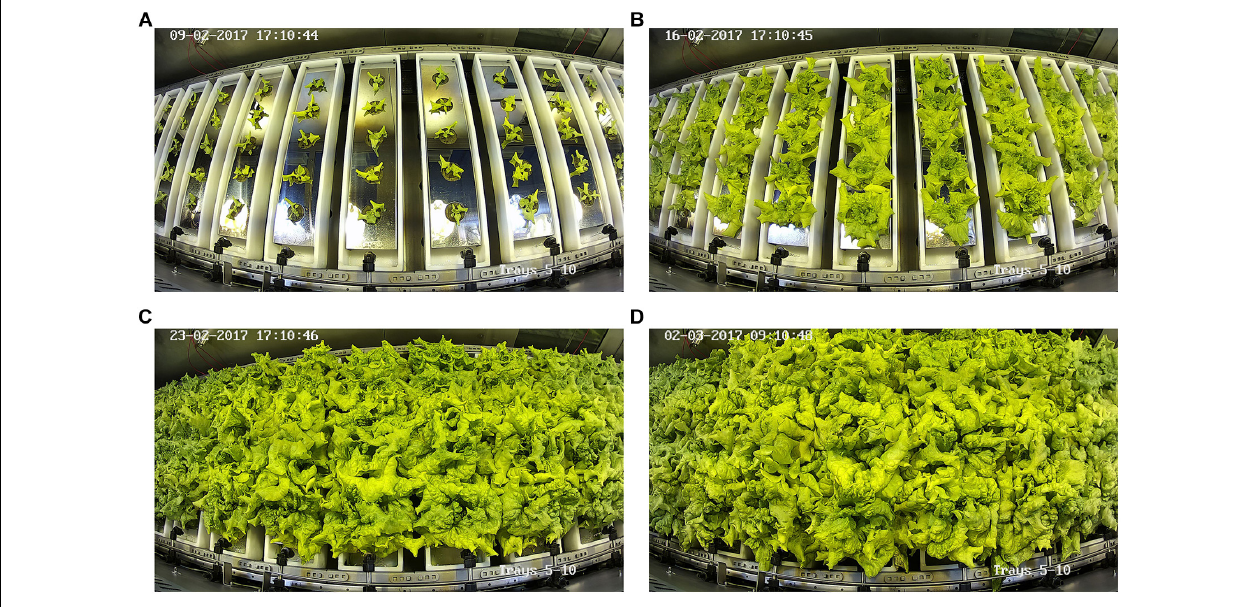
Frontiers in Plant Science |